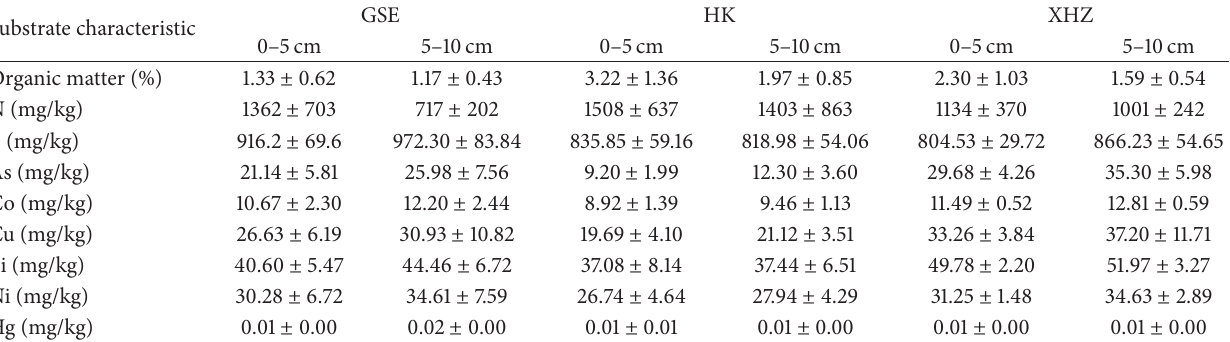
Table 3: Mean ± SD values of the principal substrate quality characteristics across the three sampling sites within the lake (Gesuer (GSE), Hekou (HK), and Xiaohaizi (XHZ)) in sediments from depths of 0–5 and 5–10 cm ( 𝑛 = 15 , 12, and 6 for GSE, HK, and XHZ, respectively).